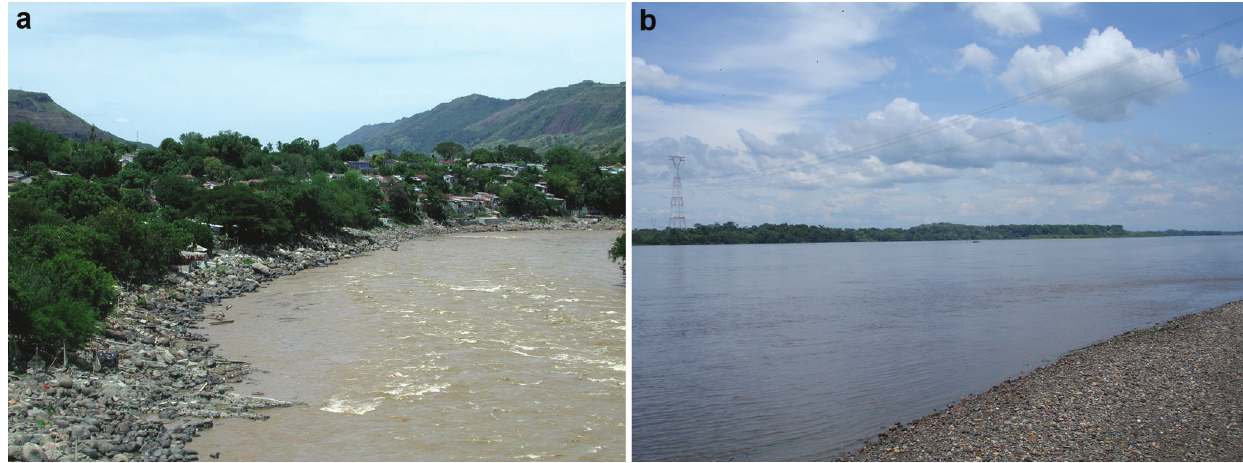
Fig. 5. General view of the habitat of Apteronotus magdalenensis in the río Magdalena. a : type locality Torrents of Honda; b : mouth of La Malena stream near Puerto Berrio in Antioquia Department (Photo a: Willian Crampton; photo b: courtesy of Pelayo-Villamil and